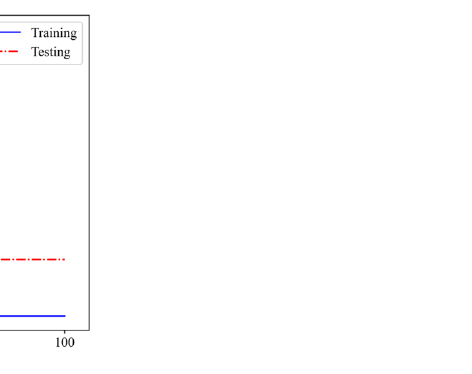
Figure 9. The RMSE curve for the increasing of